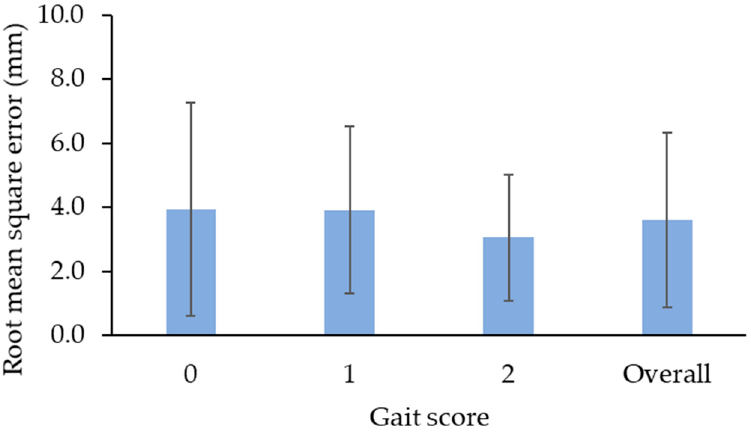
Figure 5. Root-mean-square error of key points on broilers’ backs between ground truth and pre-